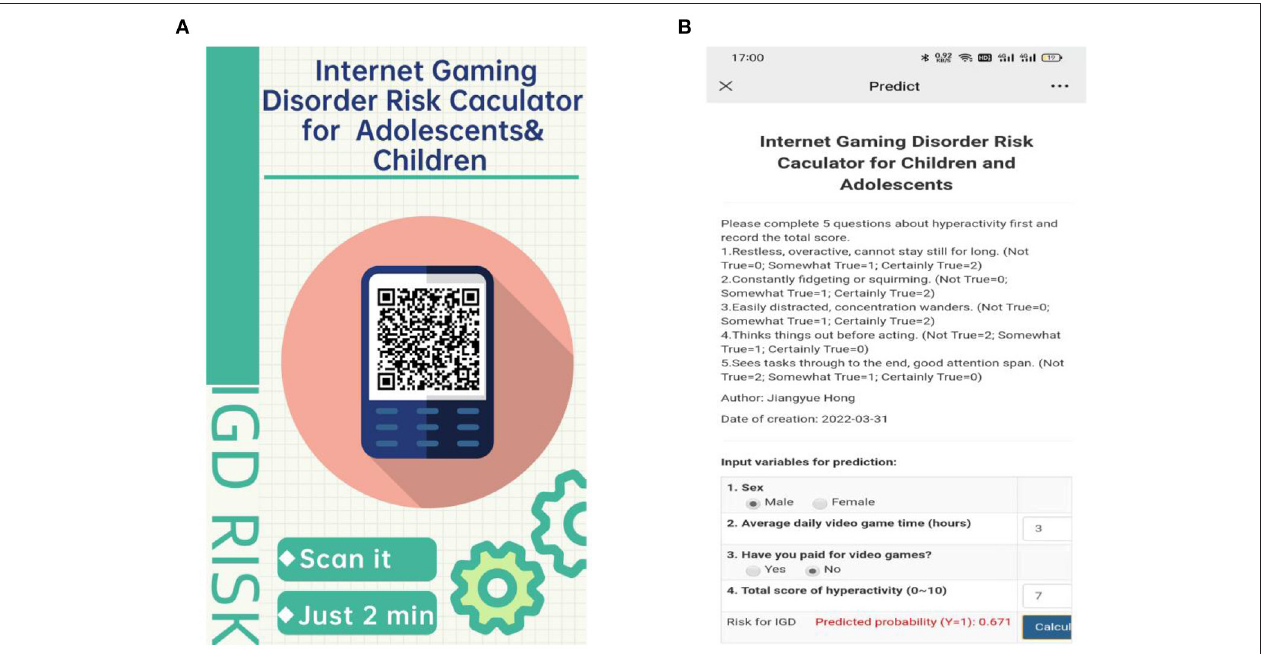
FIGURE 3 | Internet gaming disorder risk calculator for adolescents and children. (A) QR (quick response) code poster of website calculator. (B) Interactive user